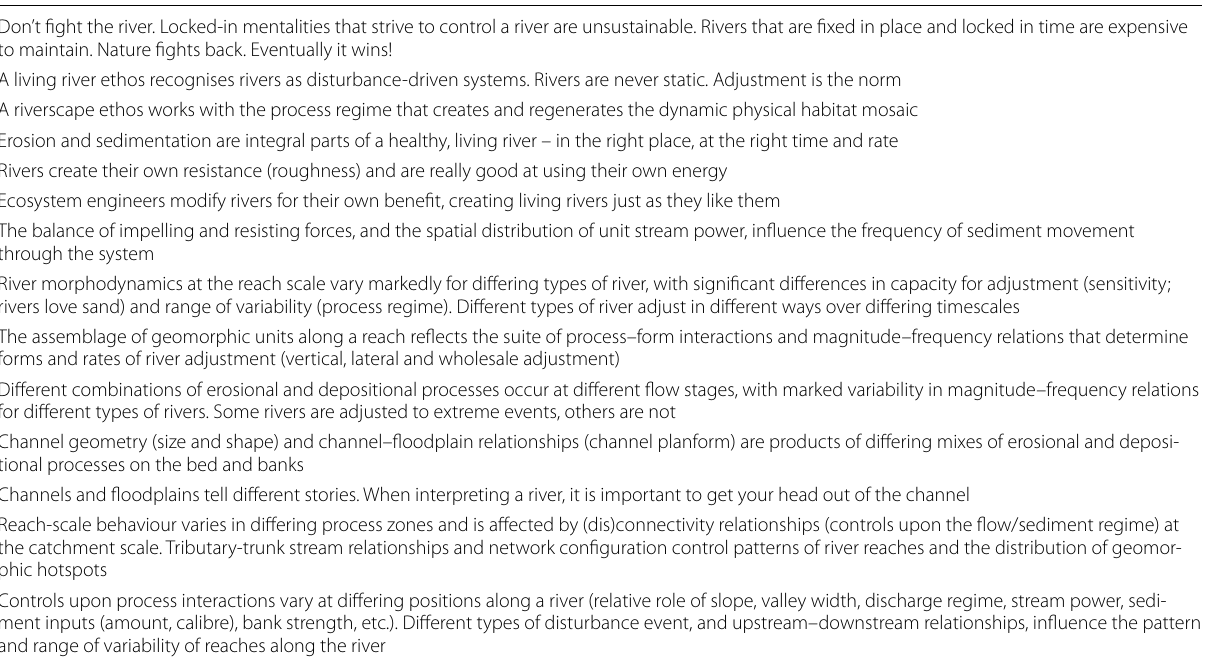
Table 4 Geomorphic principles that work with river process ( Truth 2 ) Don’t fight the river. Locked-in mentalities that strive to control a river are unsustainable. Rivers that are fixed in place and locked in time are expensive to maintain. Nature fights back. Eventually it